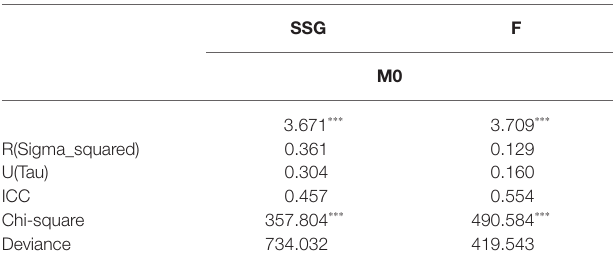
TABLE 4 | Zero model test.